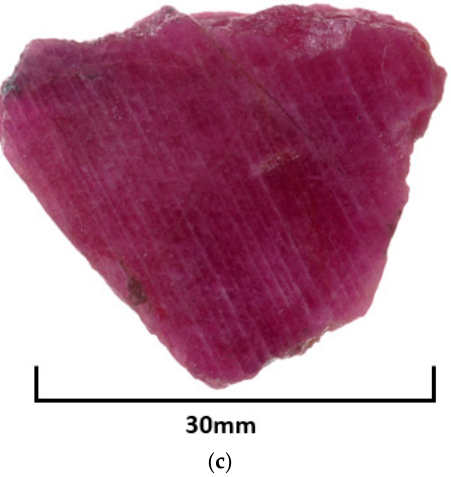
Figure 4. Images of ruby samples from Paranesti. ( a ) Dark red ruby samples from PAR-1 in pargasite schist host rock 0.5–1.0 cm; ( b ) Cluster of pale ruby samples from PAR-5 in pargasite schist host rock 0.5–1.5 cm; ( c ) Clean PAR-1 ruby sample free from inclusions used for the 2009 Oxygen Isotope